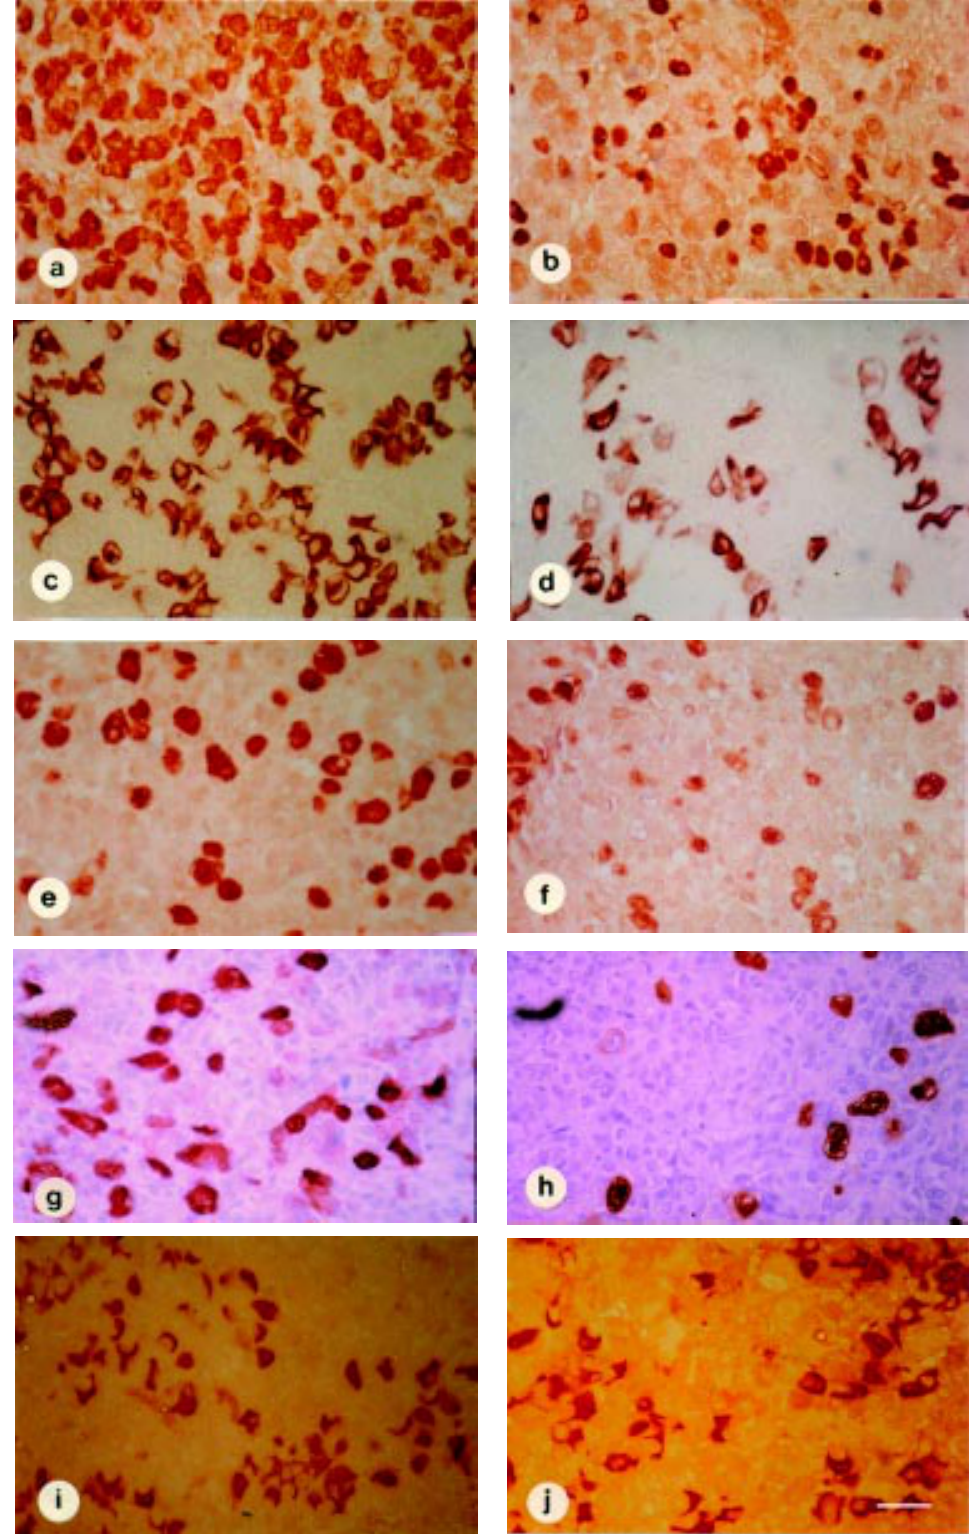
Figure 1 - Representative fields of specifically immunostained pi- tuitary cells. Somatotroph cells from male control (a) and male undernourished (b) groups. Lac- totroph cells from female con- trol (c) and female undernour- ished (d) groups. Gonadotroph cells from male control (e) and male undernourished (f) groups. Thyrotroph cells from male con- trol (g) and male undernourished (h) groups. Corticotroph cells from male control (i) and male undernourished (j) groups. EnVision system peroxidase (200X). Magnification bar: 10